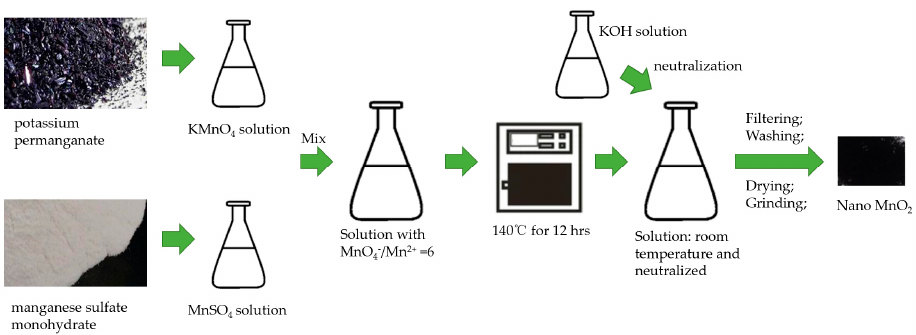
Figure 1. Schematic of Mn-Ti modified zeolite preparation.